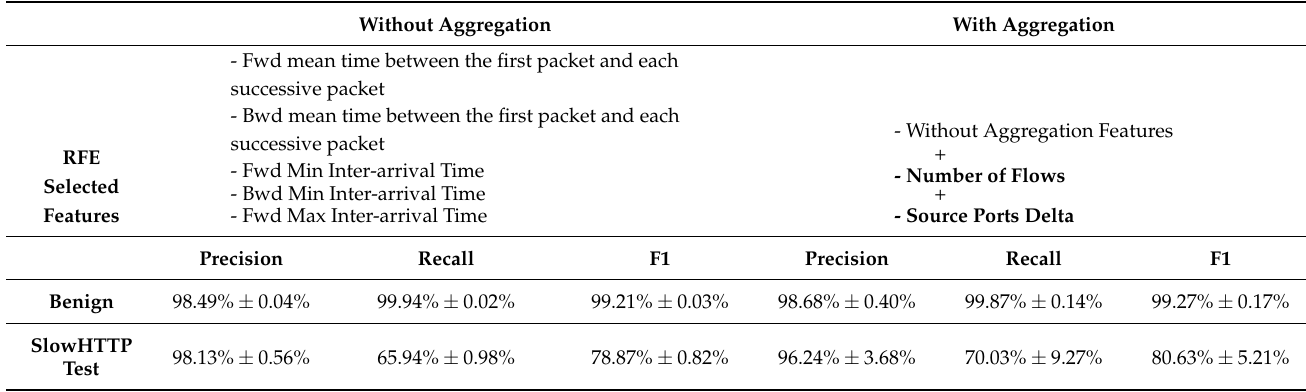
Table 5. Benign vs. SlowHTTPTest classification (5-fold cross validation).